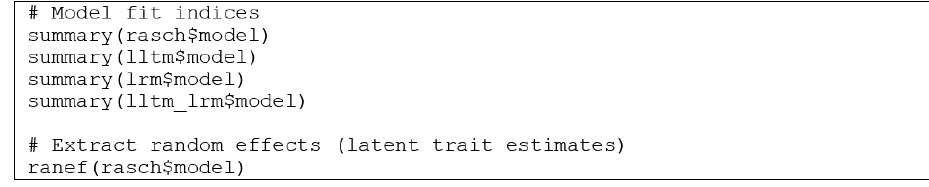
Figure 10. Extract additional information from the explanatory IRT models.